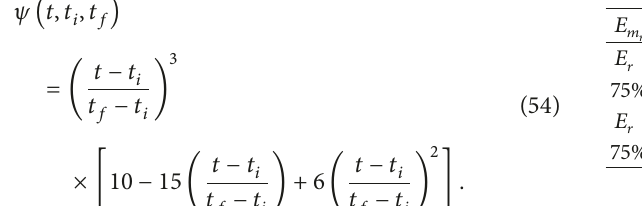
Table 4: Abrupt changes in 𝐿 𝑟 ,𝐶 𝑟 ,𝐿 𝑙 , and 𝐶 𝑙